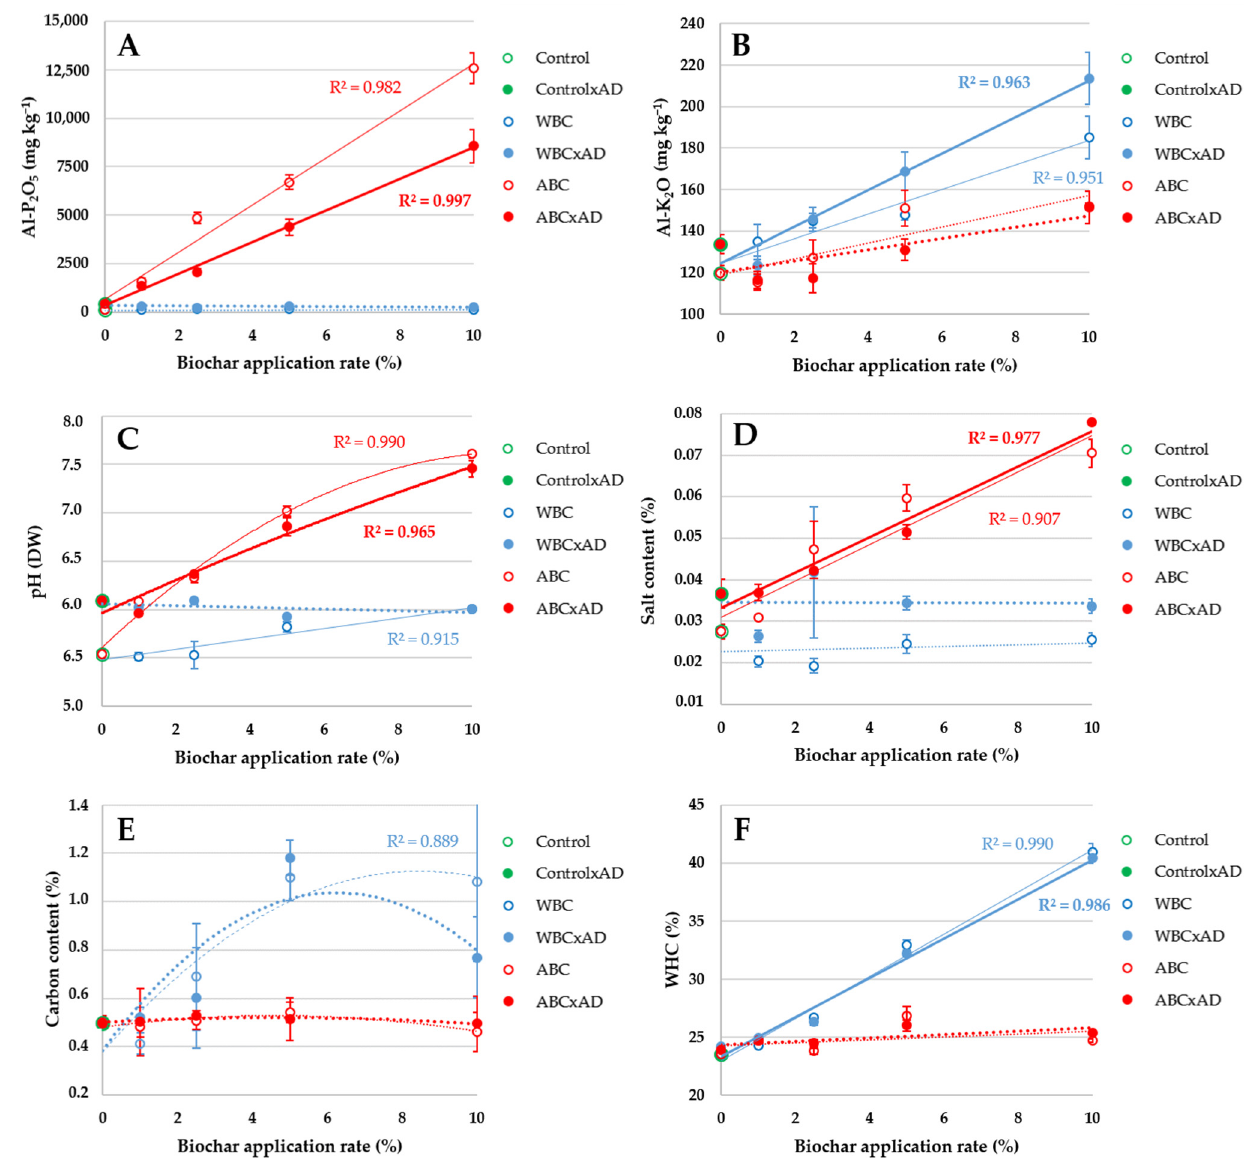
Figure 1. Effects of different biochars (ABC: animal bone biochar; WBC: wood chip biochar) and combined biochar–digestate (ABCxAD: animal bone biochar + anaerobic digestate; WBCxAD: wood chip biochar + anaerobic digestate) treatments on physical and chemical characteristics of the treated soil. ( A ): AL-P 2 O 5 content; ( B ): AL-K 2 O content; ( C ): pH (H 2 O); ( D ): water-soluble salt content; ( E ): organic carbon content; ( F ): water holding capacity. Control: without biochar and digestate; ControlxAD: anaerobic digestate treatment without biochar. On the graphs, the type of trend line represents the range of R 2 values. Solid line: R 2 = 0.900–1.000; dashed line: R 2 = 0.800–0.900; dotted line: R 2 < 0.800. The bold R 2 values and the thick lines belong to the digestate-supplemented treatments (ABCxAD and WBCxAD) in each case.